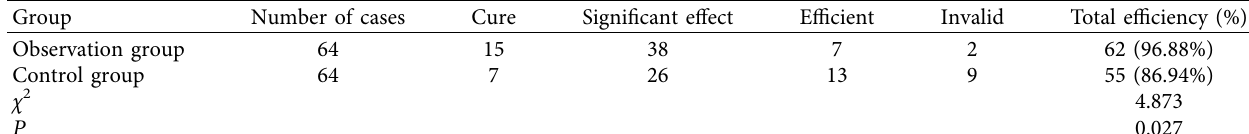
Table 1: Comparison of clinical efficacy between the two groups ( n , %).